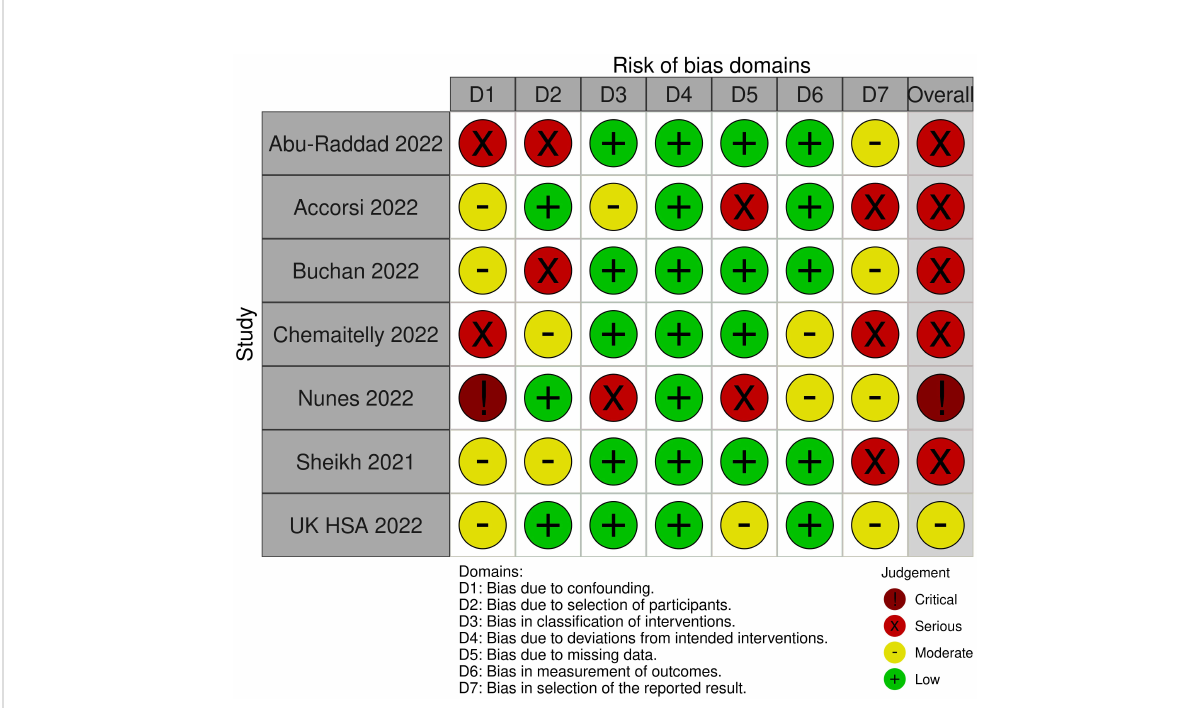
FIGURE 5 Risk of Bias assessments for the outcome "symptomatic COVID-19" due to SARS-CoV-2 infection of the Omicron